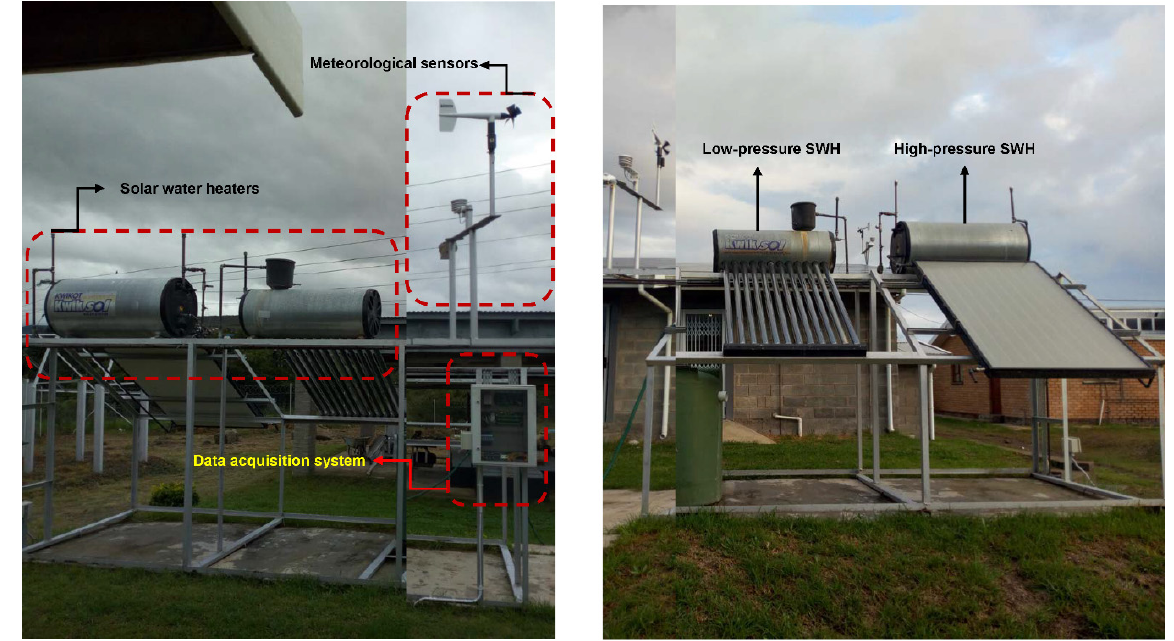
Figure 3. Outdoor test rig with installed flat plate and evacuated tube domestic solar water heaters. Table 1. Specifications of the flat plate and evacuated tube solar water heaters used in the study [34]. Technology